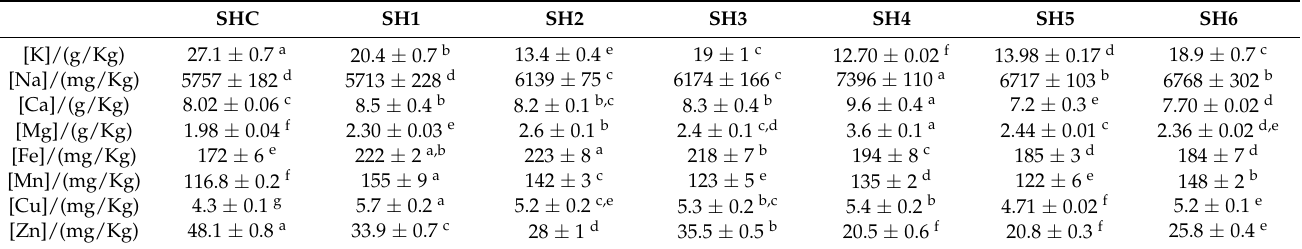
Table 6. Mineral composition in S. hispanicus leaves in relation to fertigation regime (mean ±